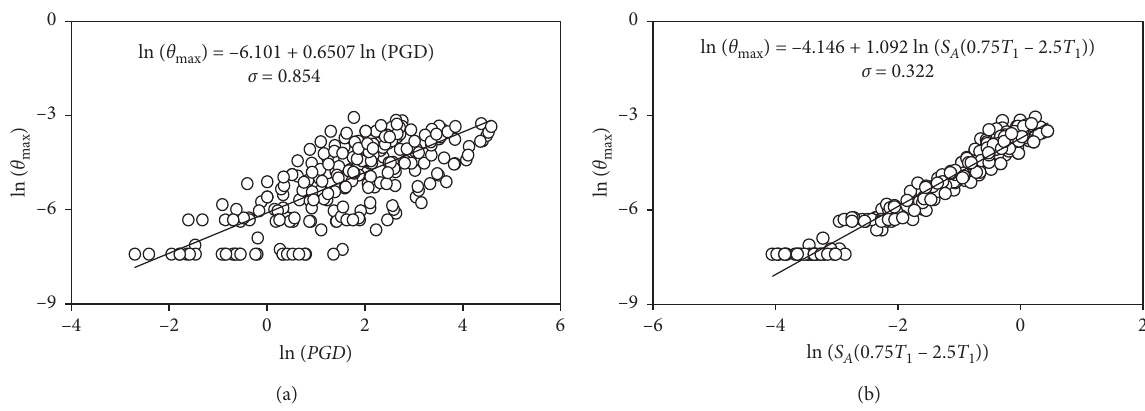
Figure 5: Comparison of the efficiency of two IMs for the symmetric model: (a) PGD; (b) S